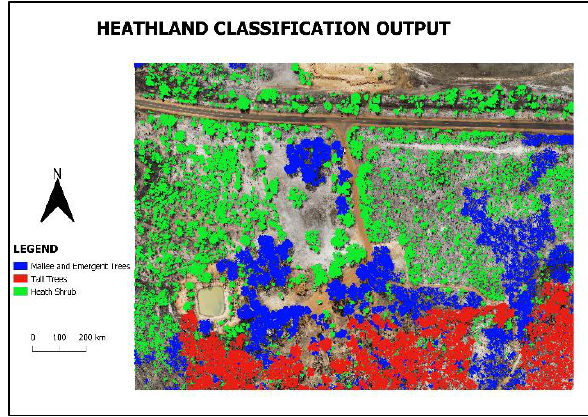
Figure 6. Classification result of the heathland voxels into three categories: 1) shrubs (in green), sparse trees and mallee (in blue) and tall trees (in